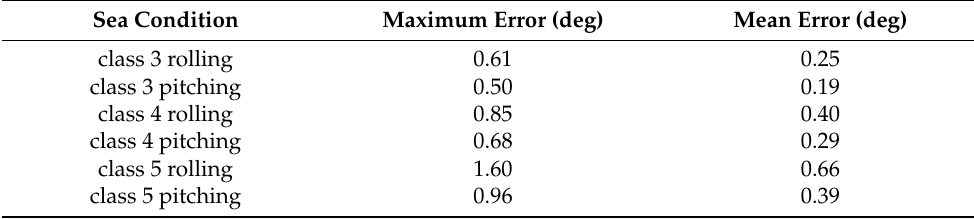
Table 3. Error analysis of the Self-Stabilized system in 3–5 level sea conditions.